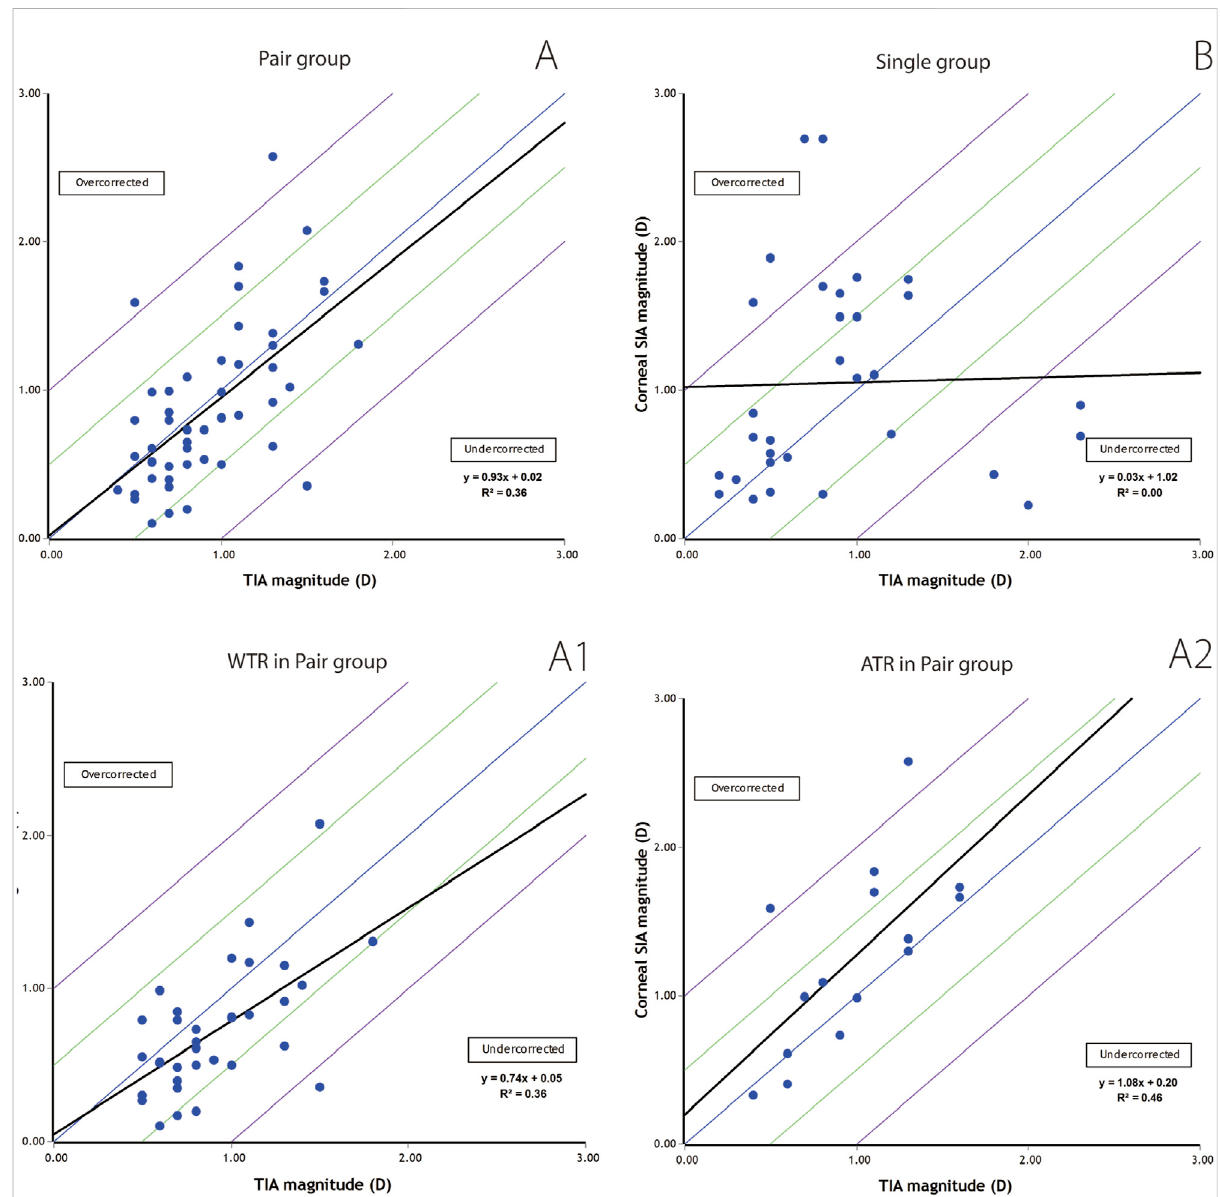
FIGURE 3 Scatterplots depicting target-induced astigmatism (TIA) vs. the surgically induced astigmatism (SIA). (A) . Cases of paired FSAK group; A1. Cases of WTR in paired FSAK group; A2. Cases of ATR in paired FSAK group and (B) . cases of single FSAK group.